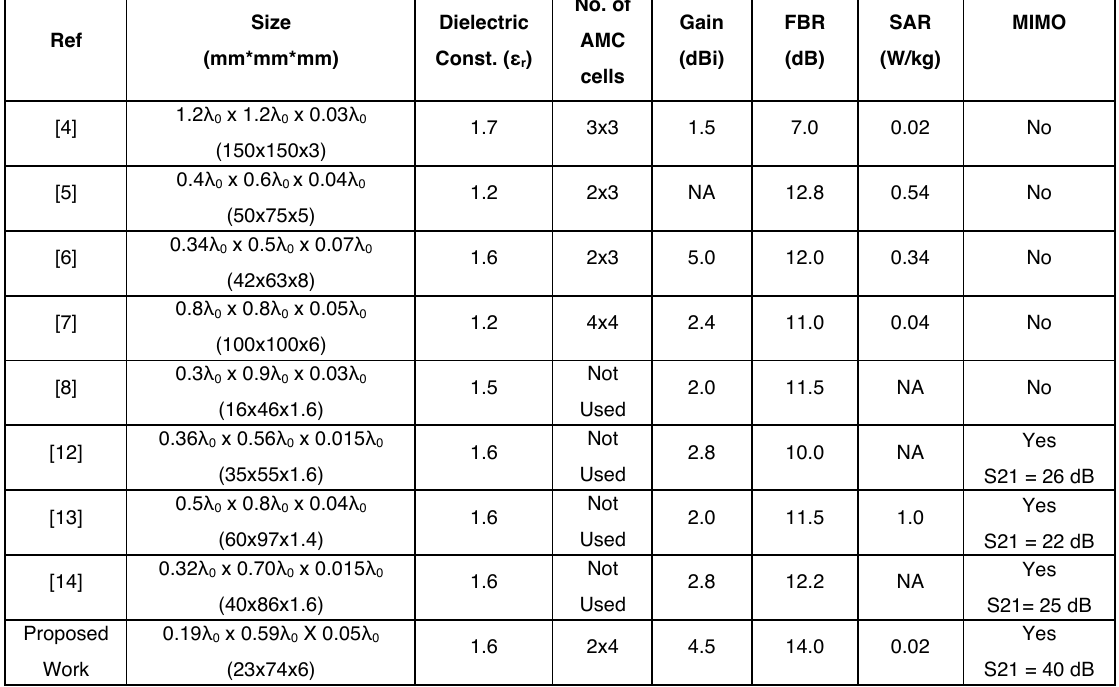
TABLE V. Comparison of the presented work to other state-of-art